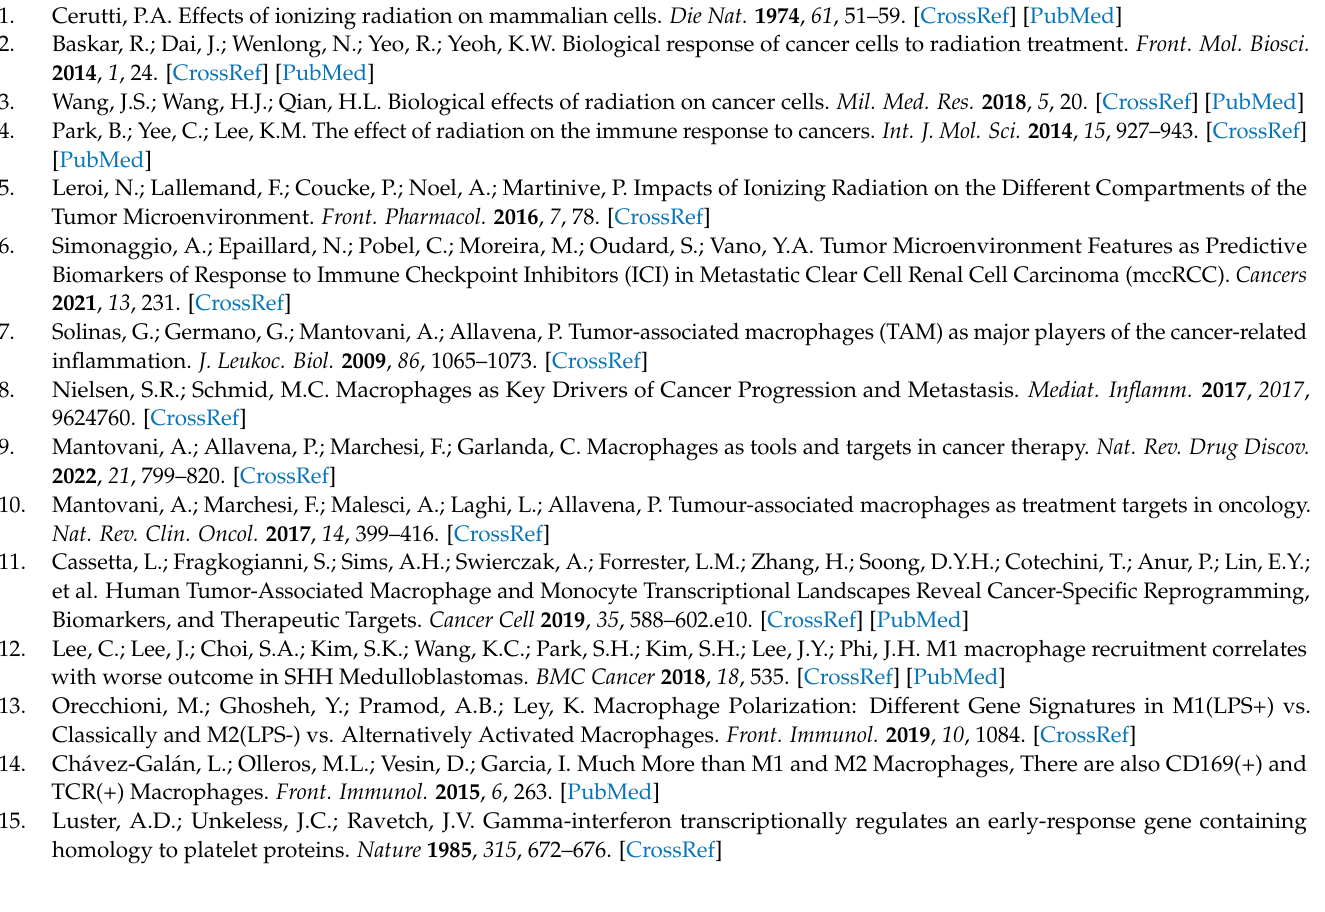
Figure S1: Results of cytokine array in irradiated J774A.1 macrophages and changes in